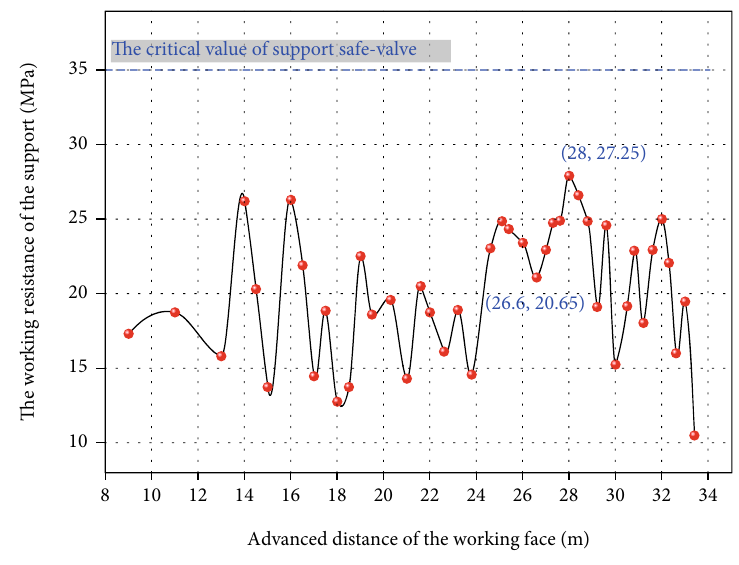
Figure 7: Working resistance of the three hydraulic supports during the initial weighting of main roof. (a) The working resistance of the No.3 measuring point (uncut side). (b) The working resistance of the No.2 measuring point (middle area). (c) The working resistance of the No.1 measuring point (roof cutting).